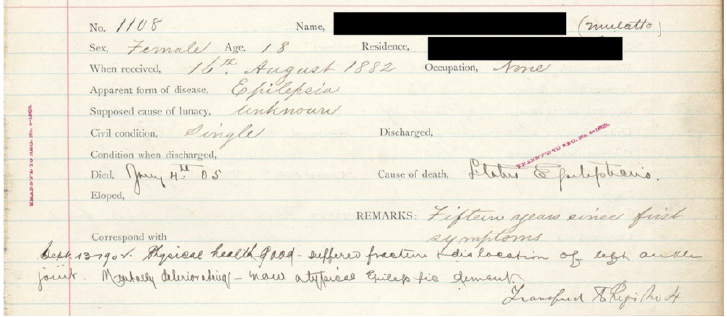
Figure 1 Central State Hospital Digital Library and Archives (CSH) record for an individual admitted in 1882 for